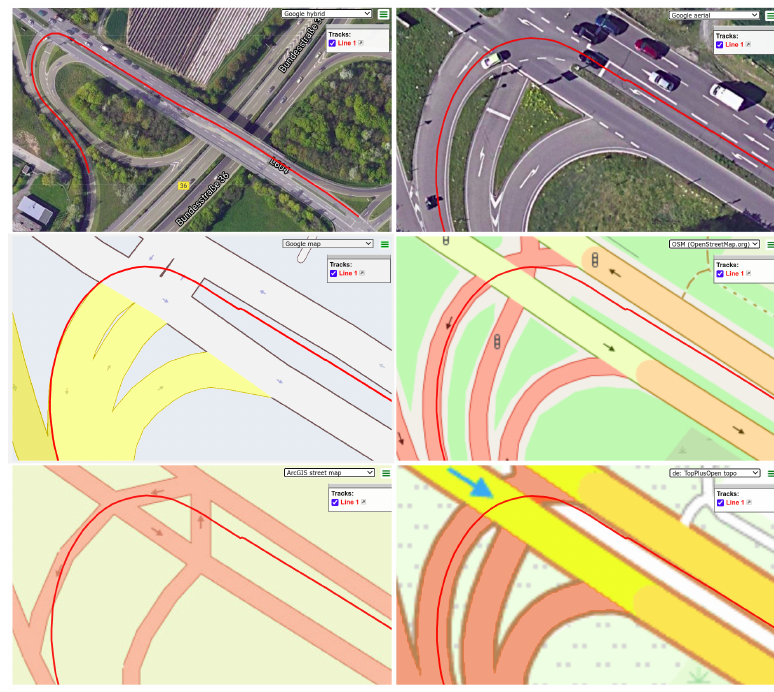
Figure 1. Integrity issues in map sources. Top-left: An example of a GPS track (in red) from the KITTI dataset projected on a satellite map from Google. Top-right: Zoomed aerial view of the track at an intersection. Middle-left: The intersection in a street map from Google. Middle-right: The intersection in a street map from OpenStreetMap. Bottom-left: The intersection in a street map from ArcGIS. Bottom-right: The intersection in a street map from the Federal Agency for Cartography and Geodesy (BKG) of